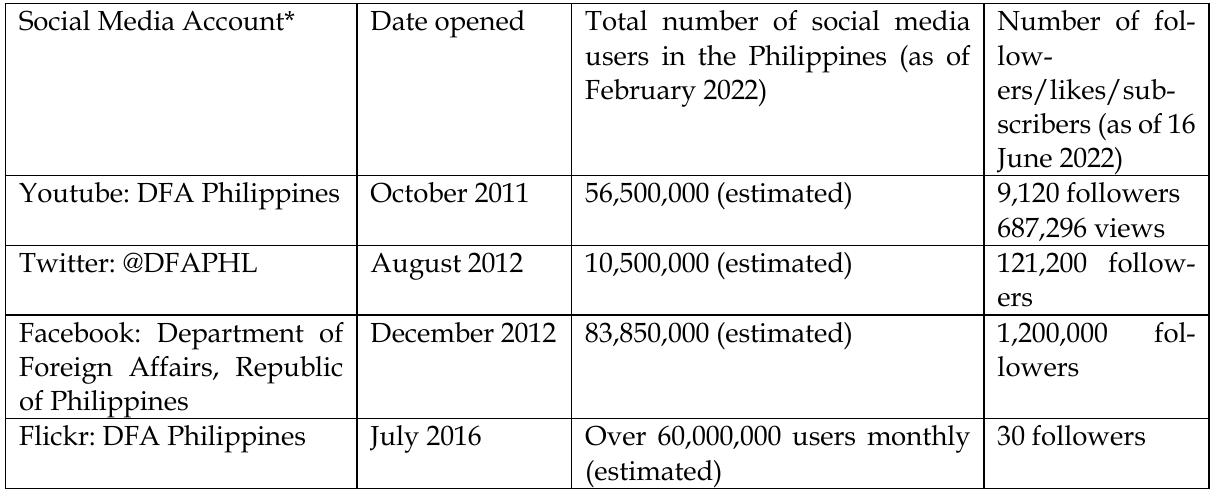
Table 1: DFA Social Media